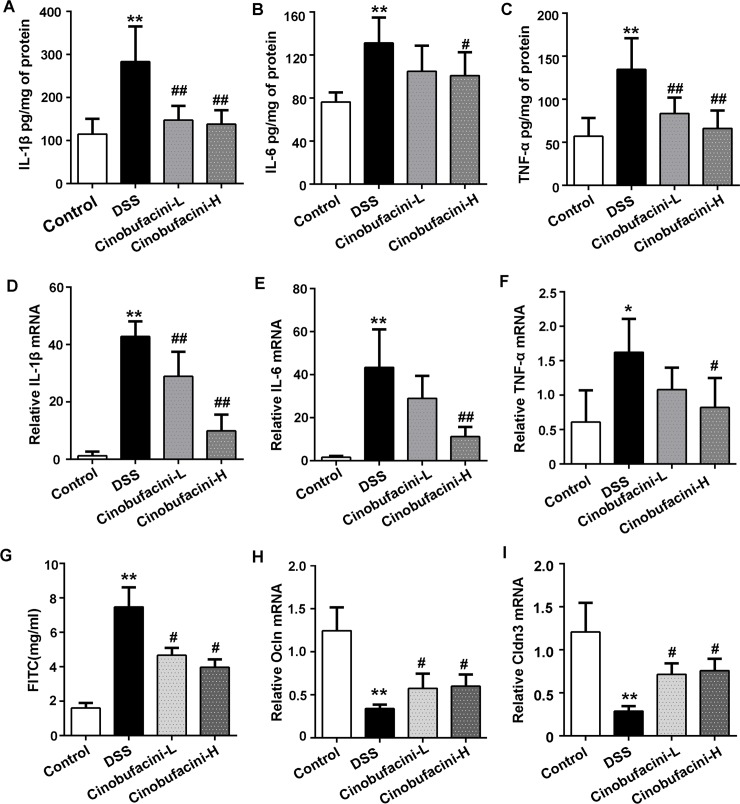
Cinobufacini reduced the production of inflammatory cytokines and intestinal permeability.(A, B, C) Measurement of inflammatory cytokines in mouse blood samples. (D, E, F) mRNA level of inflammatory cytokines in the colon tissues (G) FITC-Dextran permeability testing. (H, I) The expression of key molecular components of tight junctions. Cinobufacini-L, 10.0 mg/kg body weight cinobufacini treatment; cinobufacini-H, 30.0 mg/kg body weight. Data are represented as the mean ± SD of three experimental replicates. *p < 0.05, **p < 0.01 vs the control group; #p < 0.05, ##p < 0.01 vs the DSS group. n = 8 mice per group.